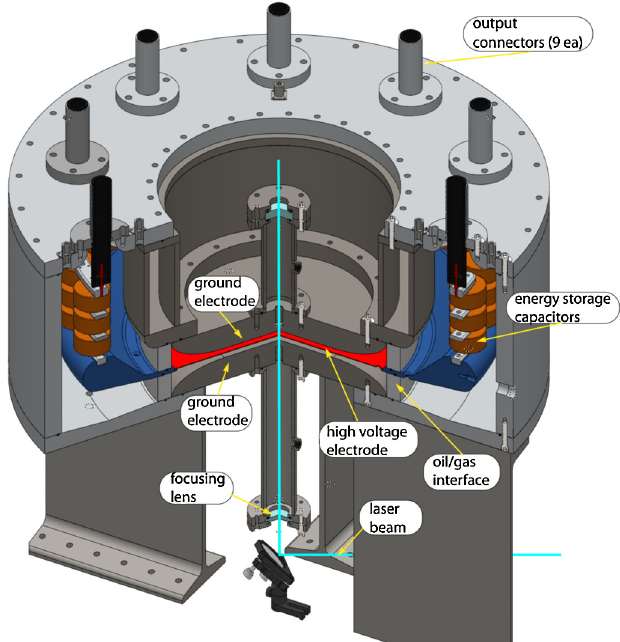
FIG. 2. (Color) The laser-triggered low-inductance switch and pulse generator system. The electrode gap in the center is 7 mm.